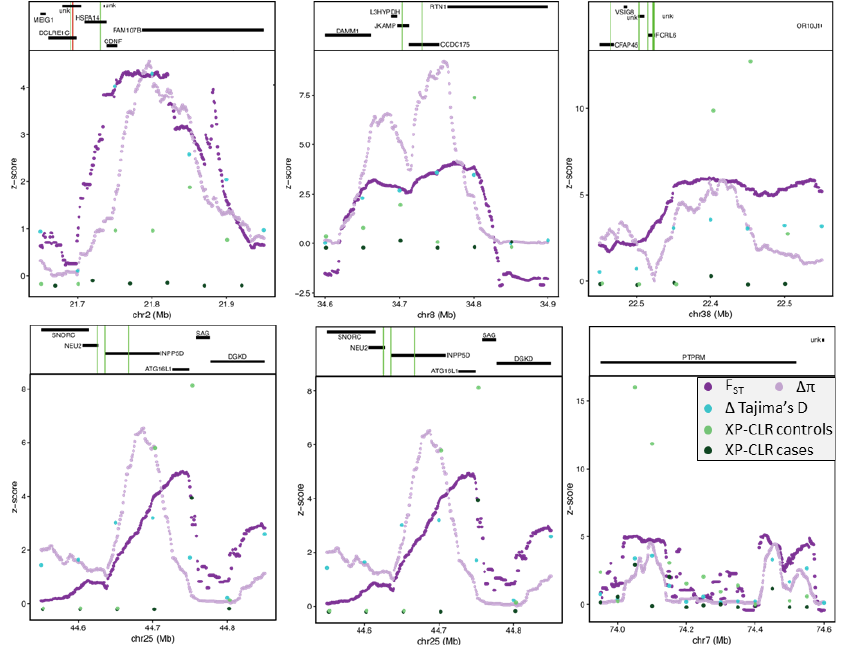
Figure 3. Z − transformed selection scan statistics (bottom) and gene annotations (top) plotted across the top 16 ranked candidate regions highly differentiated between case and SCA controls. F ST (purple), ∆ π (lavender), ∆ Tajima’s D (turquoise), and XP-CLR (CO: control (light green); CA: case (dark green)). Gene annotation show genes as black horizontal bars with missense mutations as green vertical lines and stop-gained mutations as red vertical lines.